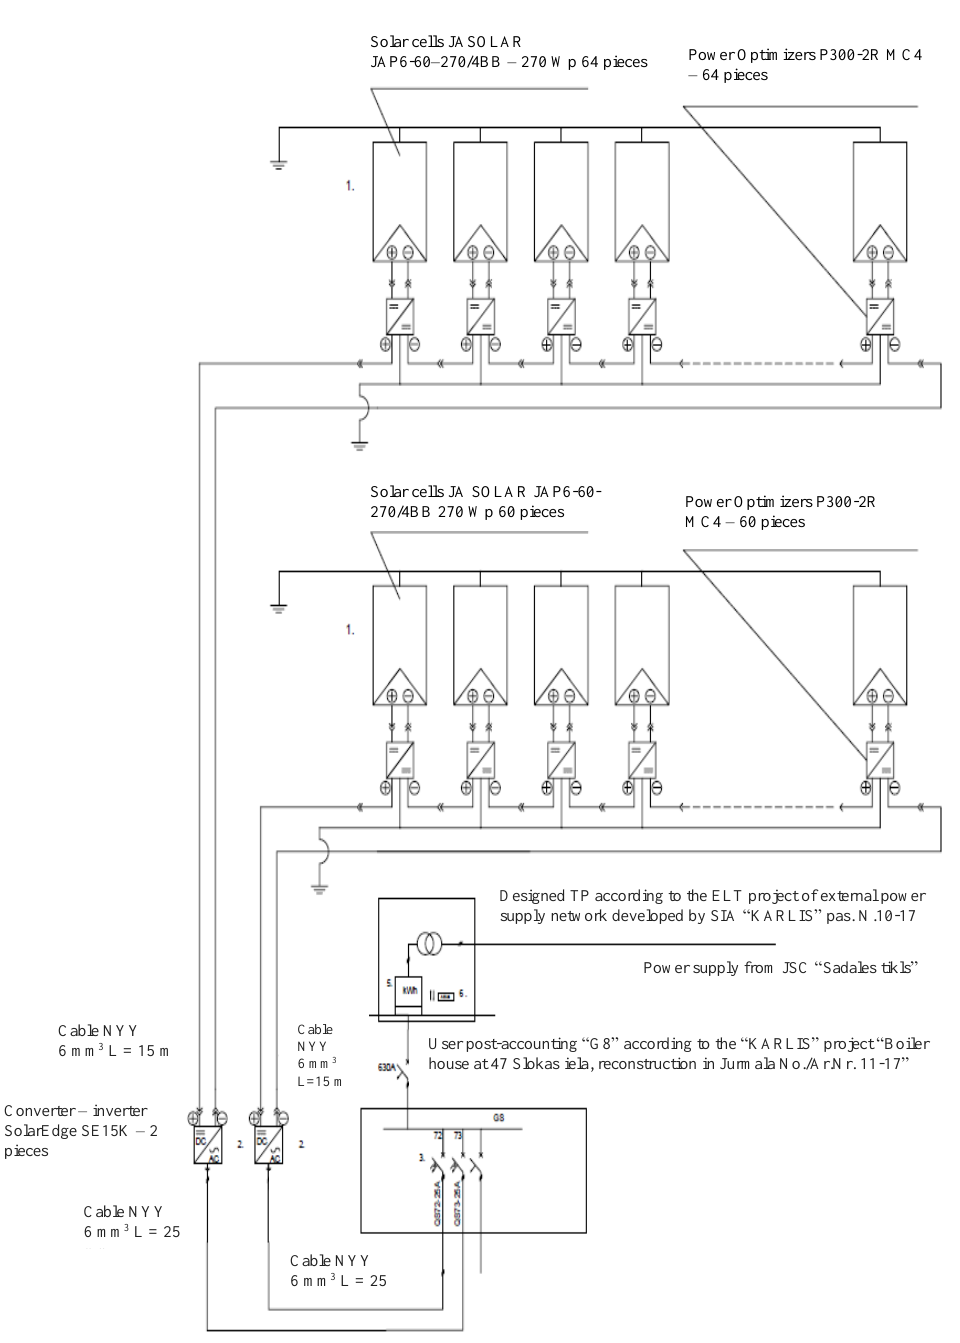
Fig. 4. Connection scheme of solar power plant with nominal capacity 30 kW for parallel operation with JSC “Sadales Tikls” electricity